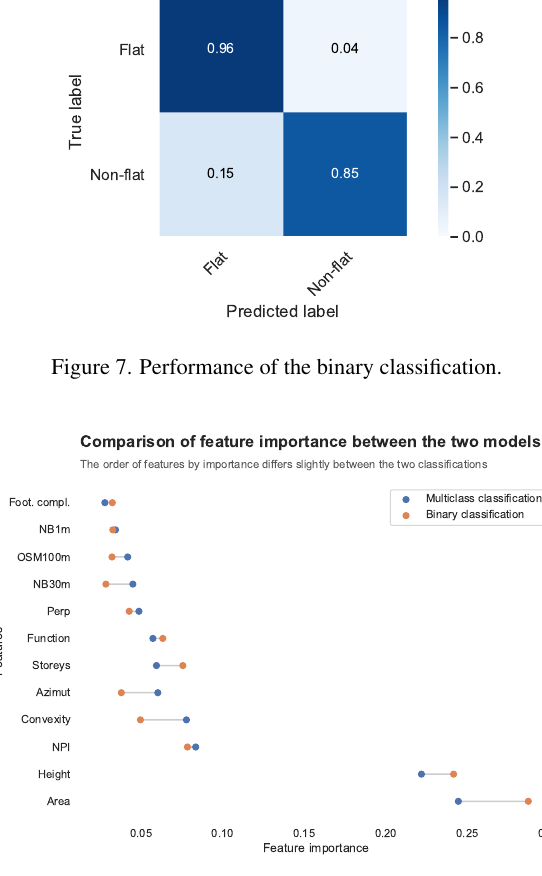
Figure 8. Feature importance of the two approaches. Some pre- dictors are more important than